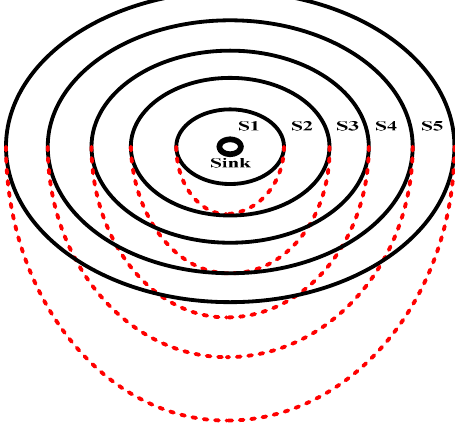
Figure 5. Layering in SEANAR.